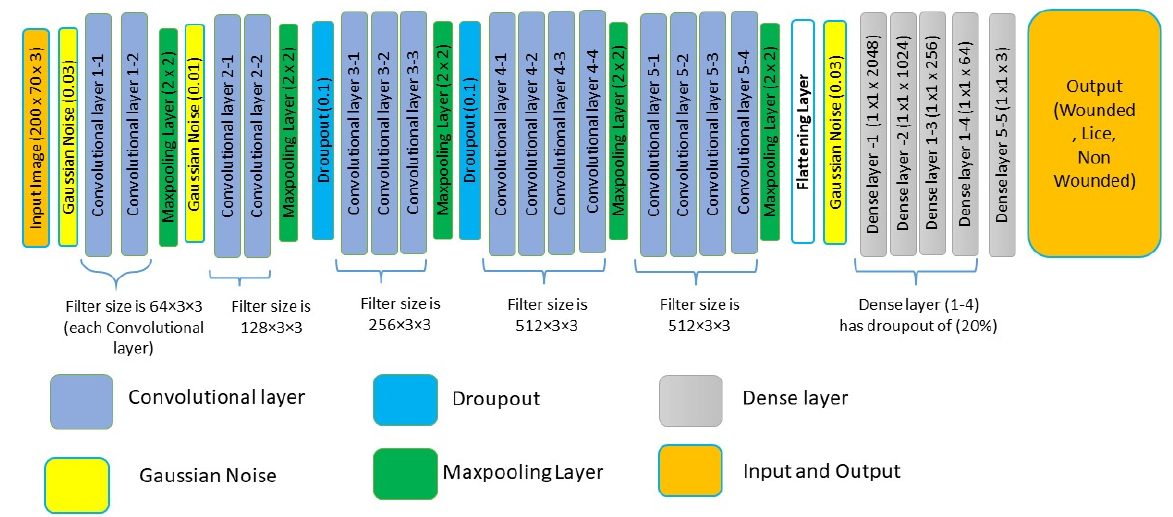
Figure 5. Proposed convolutional neural network model.